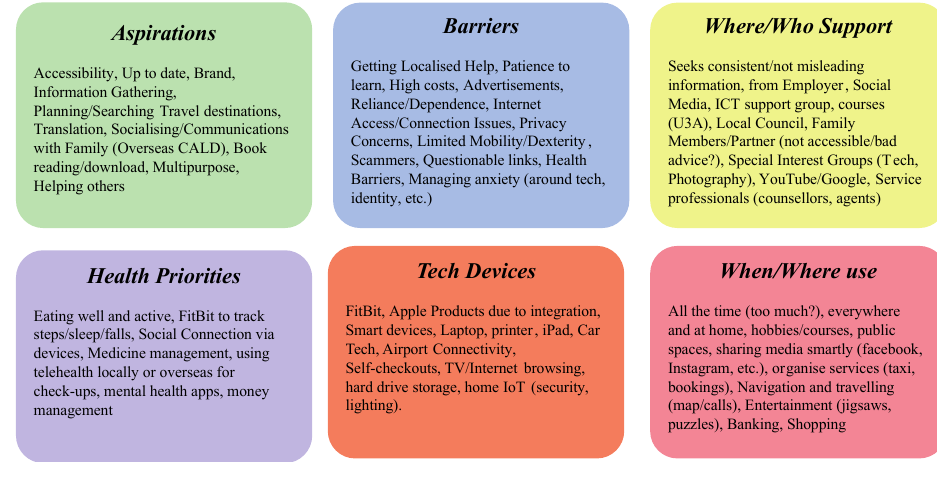
Figure 6. Highly literate persona.